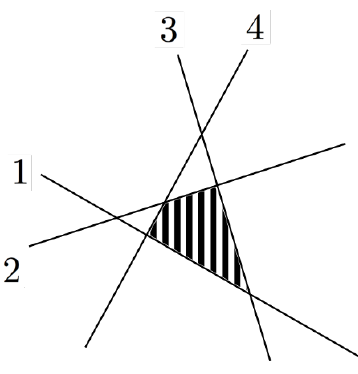
Figure 3 . A quadrilateral in CP 2 (cid:3) de(cid:12)ned by four lines labeled by i according to the points f Z (cid:11) g 1 (cid:20) i (cid:20) 4 in CP 2 that de(cid:12)ne them. i